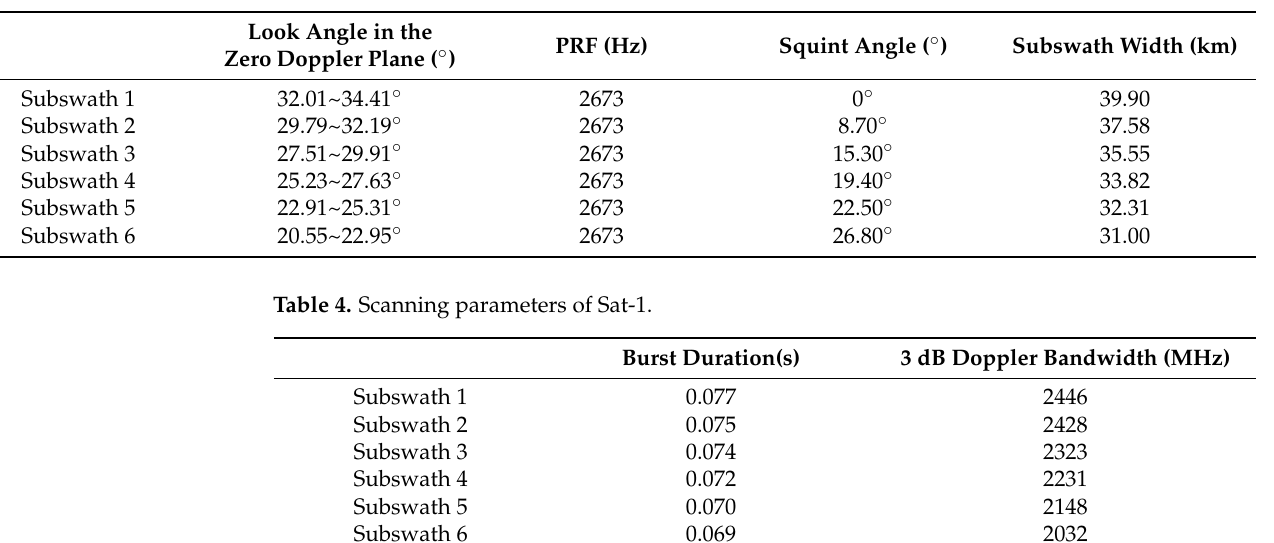
Table 3. Beam position parameters of six subswaths.